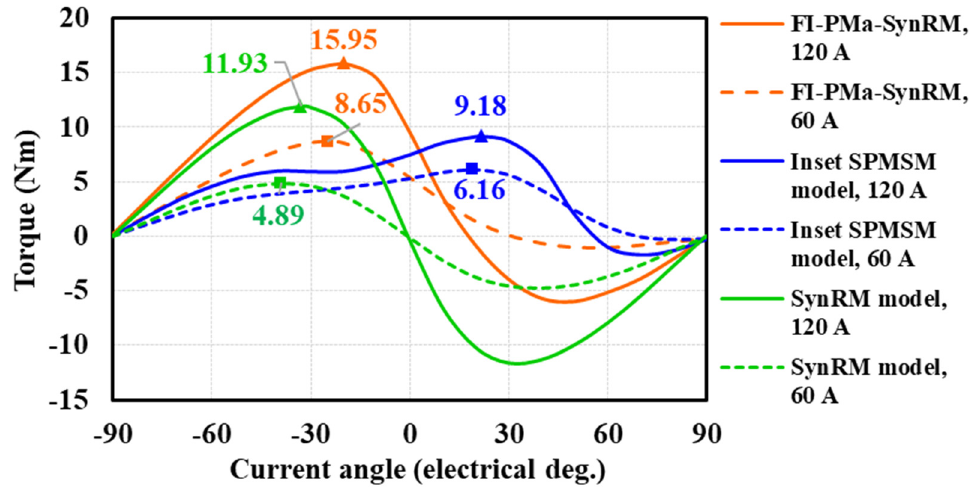
Figure 8. Torque productions vs current angle/phase advance.